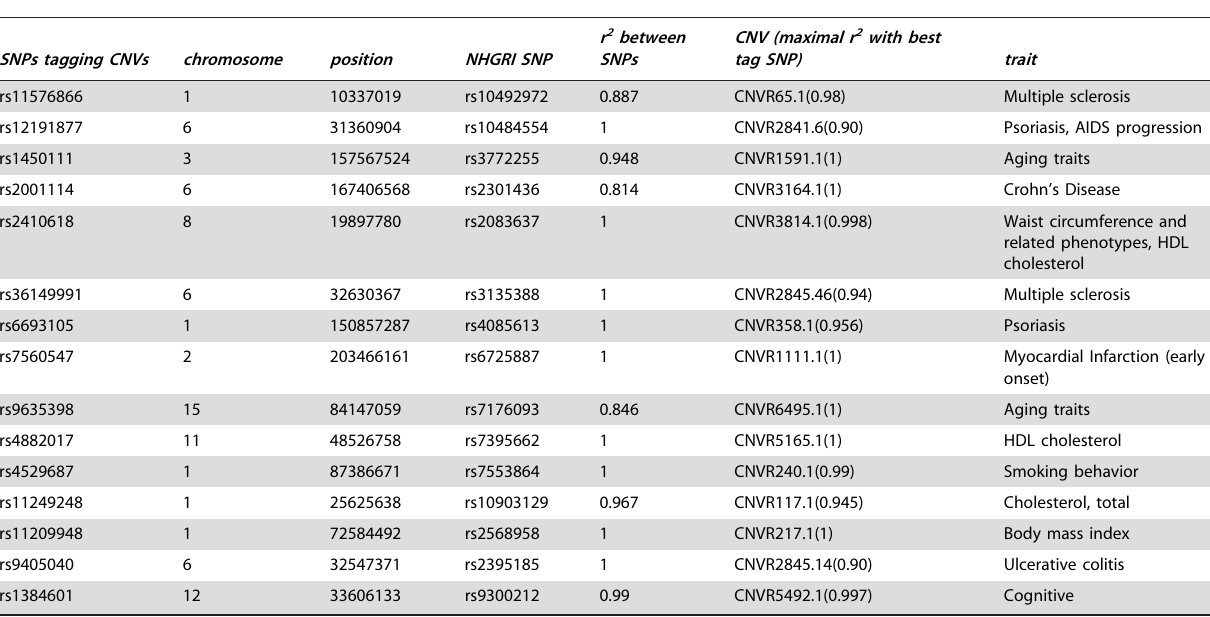
Table 2. The observed overlap between the NHGRI SNPs and SNPs tagging CNVs ( r 2 $ 0.80).